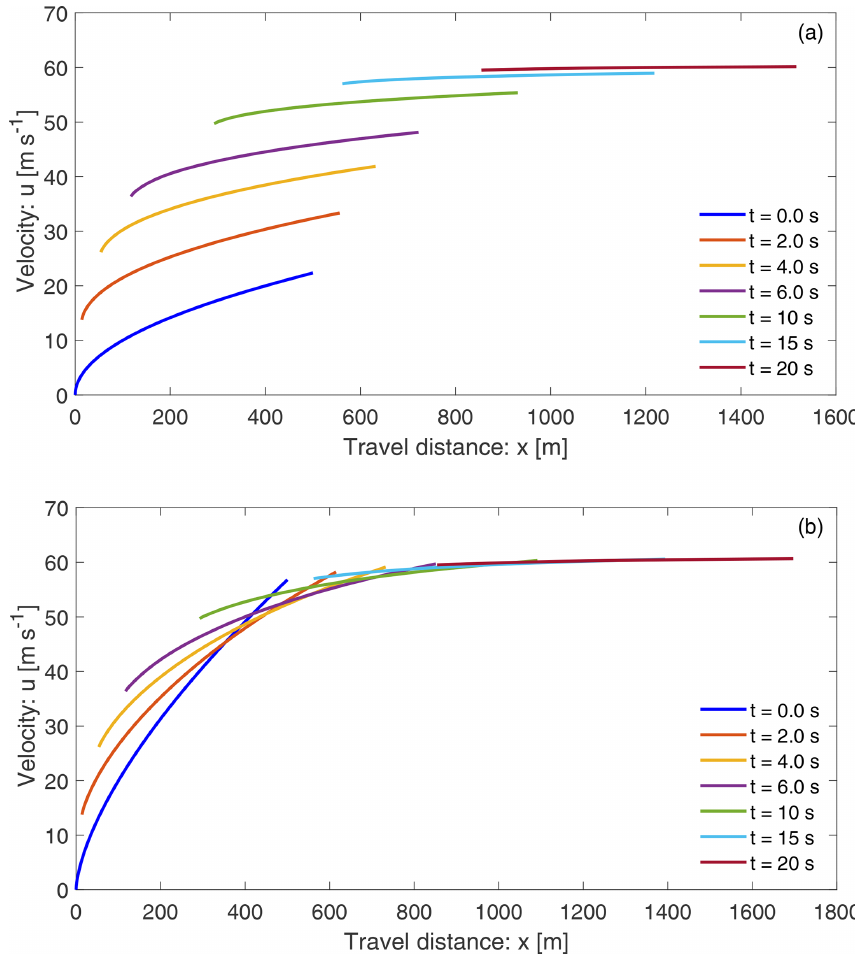
Figure 9. Time evolution of velocity profiles of propagating and stretching landslides down a slope and as functions of position including the internal deformations as given by the general solution in Eqs. (39) and (40) of Eq. (5). The profiles evolve based on the initial conditions s 0 ( x ) = x 0 . 50 ( a , t = 0 . 0s) and s 0 ( x ) = x 0 . 65 ( b , t = 0 . 0s),